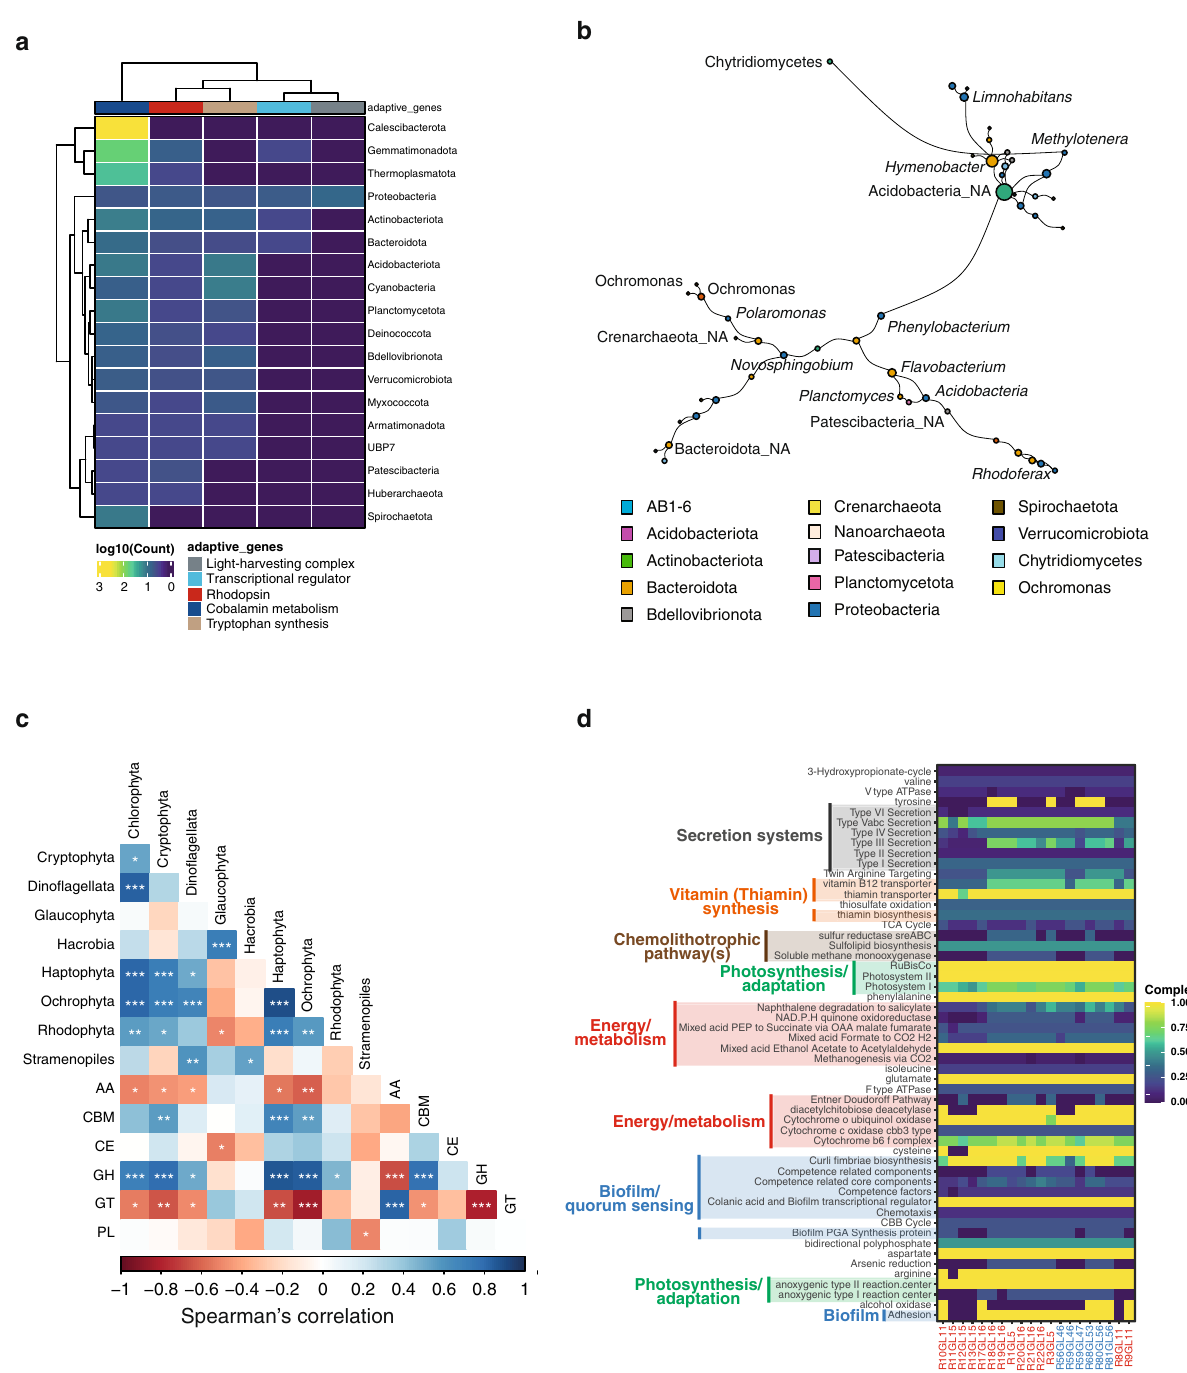
Fig. 3 Epilithic bio fi lms are the basis for a ‘ green food chain ’ . a Abundance of genes involved in energy production (light-harvesting complex, transcriptional regulator for phototrophy, and rhodopsin) and photo-heterotrophic interactions (cobalamin metabolism and tryptophan synthesis), across all prokaryotic phyla are represented in the heatmap. Values indicate the log 10 abundance per gene within the phyla. b Largest component of the co- occurrence network between pro- and eukaryotic MAGs. Each node corresponds to a MAG (pro- or eukaryote). Size of the node corresponds to degree centrality and the edges represent the positive coef fi cients of correlation between each node. Colour of each node represents the phylum annotation. NA: unclassi fi ed genus. c Spearman ’ s correlation analyses of relative abundances of eukaryotic primary producers with the CAZyme abundances. CAZymes include AA auxilliary activities, CBM carbohydrate-binding module, CE carbohydrate esterases, GH glycoside hydrolases, GT glycosyltransferases, PL polysaccharide lyases. FDR-adjusted p values were estimated using the ‘ cor.mtest ’ function from the corrplot R package and are indicated by *, i.e., *<0.05, **<0.01, ***<0.001. d KEGG orthology (KO) pathways enriched in epilithic bio fi lms compared to publicly available cryospheric metagenomes were further assessed via KEGGDecoder for pathway completion and are displayed. The completeness of the pathways is indicated in the heatmap, per